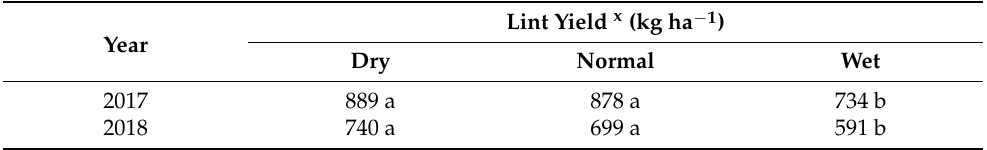
Table 9. Mean lint yield averaged across seeding depths, downforces and cultivars in different at-plant field conditions in 2017 and